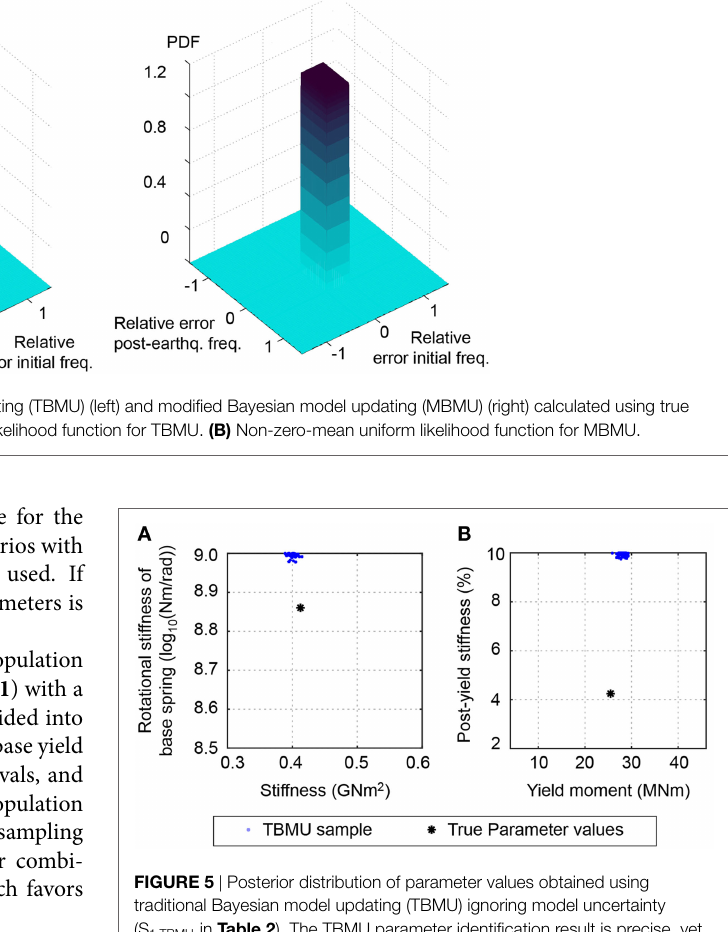
FIGURE 5 | Posterior distribution of parameter values obtained using traditional Bayesian model updating (TBMU) ignoring model uncertainty (S 1,TBMU in Table 2 ). The TBMU parameter identification result is precise, yet biased and inaccurate. Modified Bayesian model updating and error-domain model falsification falsified the entire model class. (A) Linear parameters. (B) Non-linear